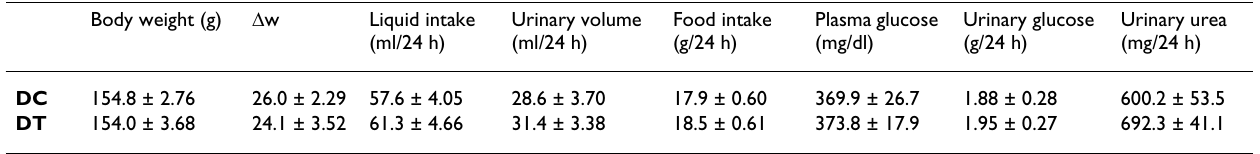
Table 1: Physiological and metabolic variables for streptozotocin-diabetic